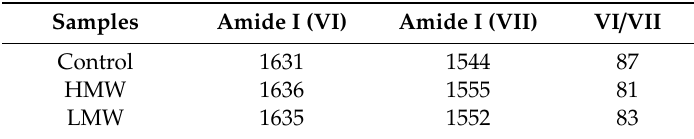
Table 2. Wavenumber of amide I (V I ) and amide II (V II ) bands, as well as the wavenumber difference between them (V I –V II ), for control scaffolds and collagen scaffolds with HMW and LMW chitosan.